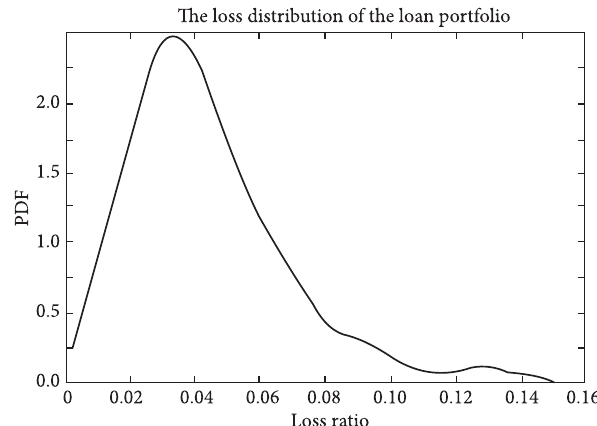
Figure 5. The loss distribution of the loan portfolio (source: own